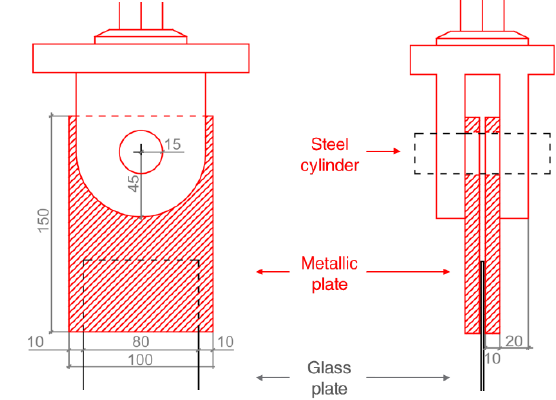
Fig. 17 Tension test setup, front (left) and side (right)